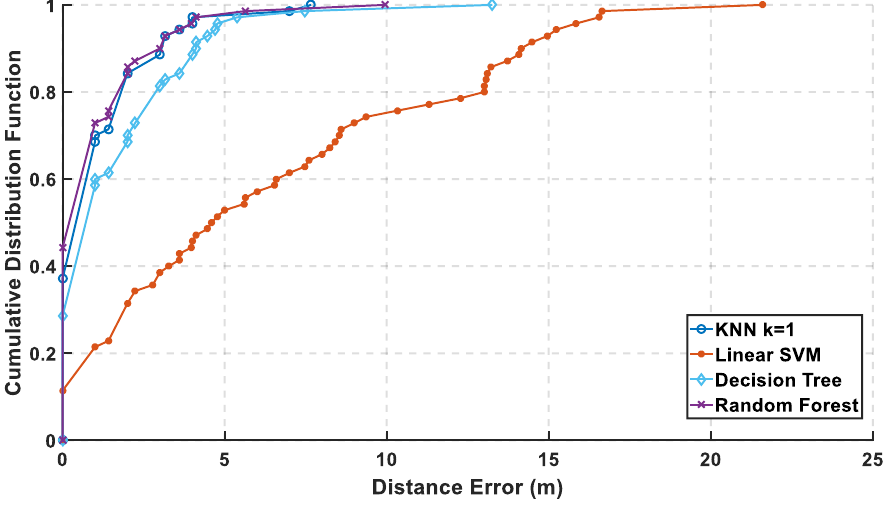
Figure 13. Cumulative Distribution Function (CDF) Error of the Classifier without PCA.